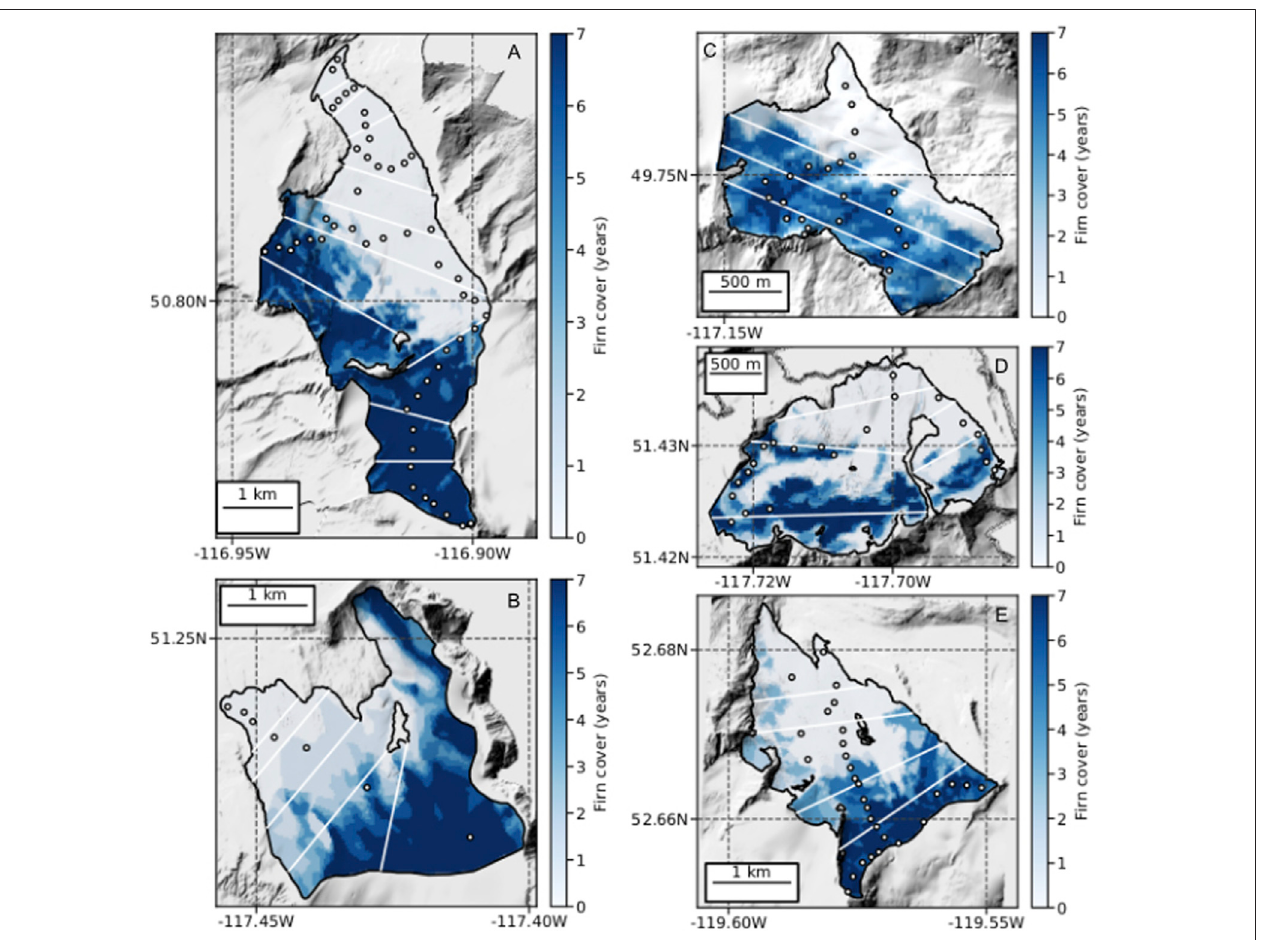
FIGURE4| Accumulationareacoveragederivedfrommergingallrecentaccumulationareamasksfrom2012to2018for (A) Conrad, (B) Illecillewaet, (C) Kokanee, (D) Nordicand (E) Zillmerglaciers.Forapixelwithavalueofseven,thatpixelretainedaccumulationinallsevenyears.Avalueofzeroimpliesabareicesurfaceinallyears. Flux gates are white lines and glaciological observations are white dots with black outline.